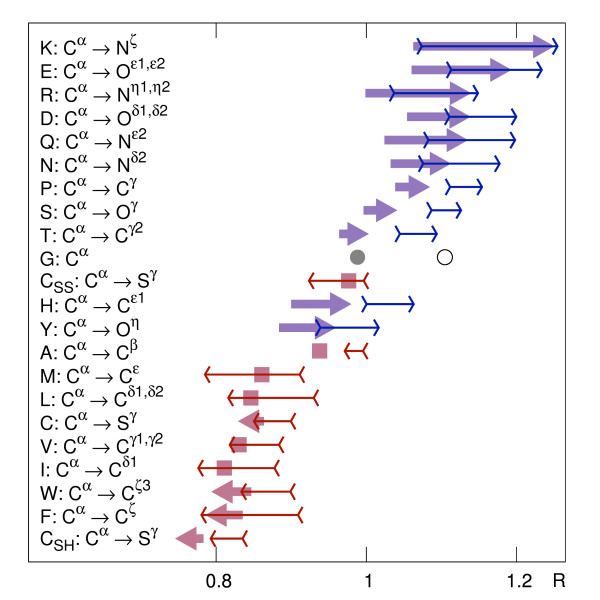
Orientational preferences of amino acids in globular proteins. Locations of mean and maximum values of probability density functions for Cα and most distant side chain atoms for all amino acids. Thick arrows connect means; thin arrows span between maxima of distributions. All arrows point towards the most distal atom in the side chain (except for Gly) according to the labels on the left. The arrows that would be shorter than their heads are replaced by squares.